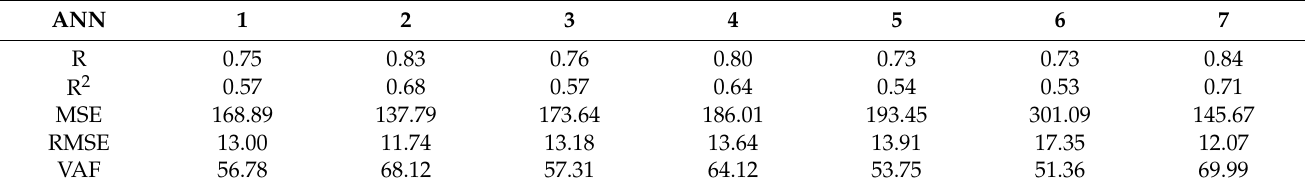
Table 12. Statistical indices of the ANN models for calculation of CLI from other rock properties.